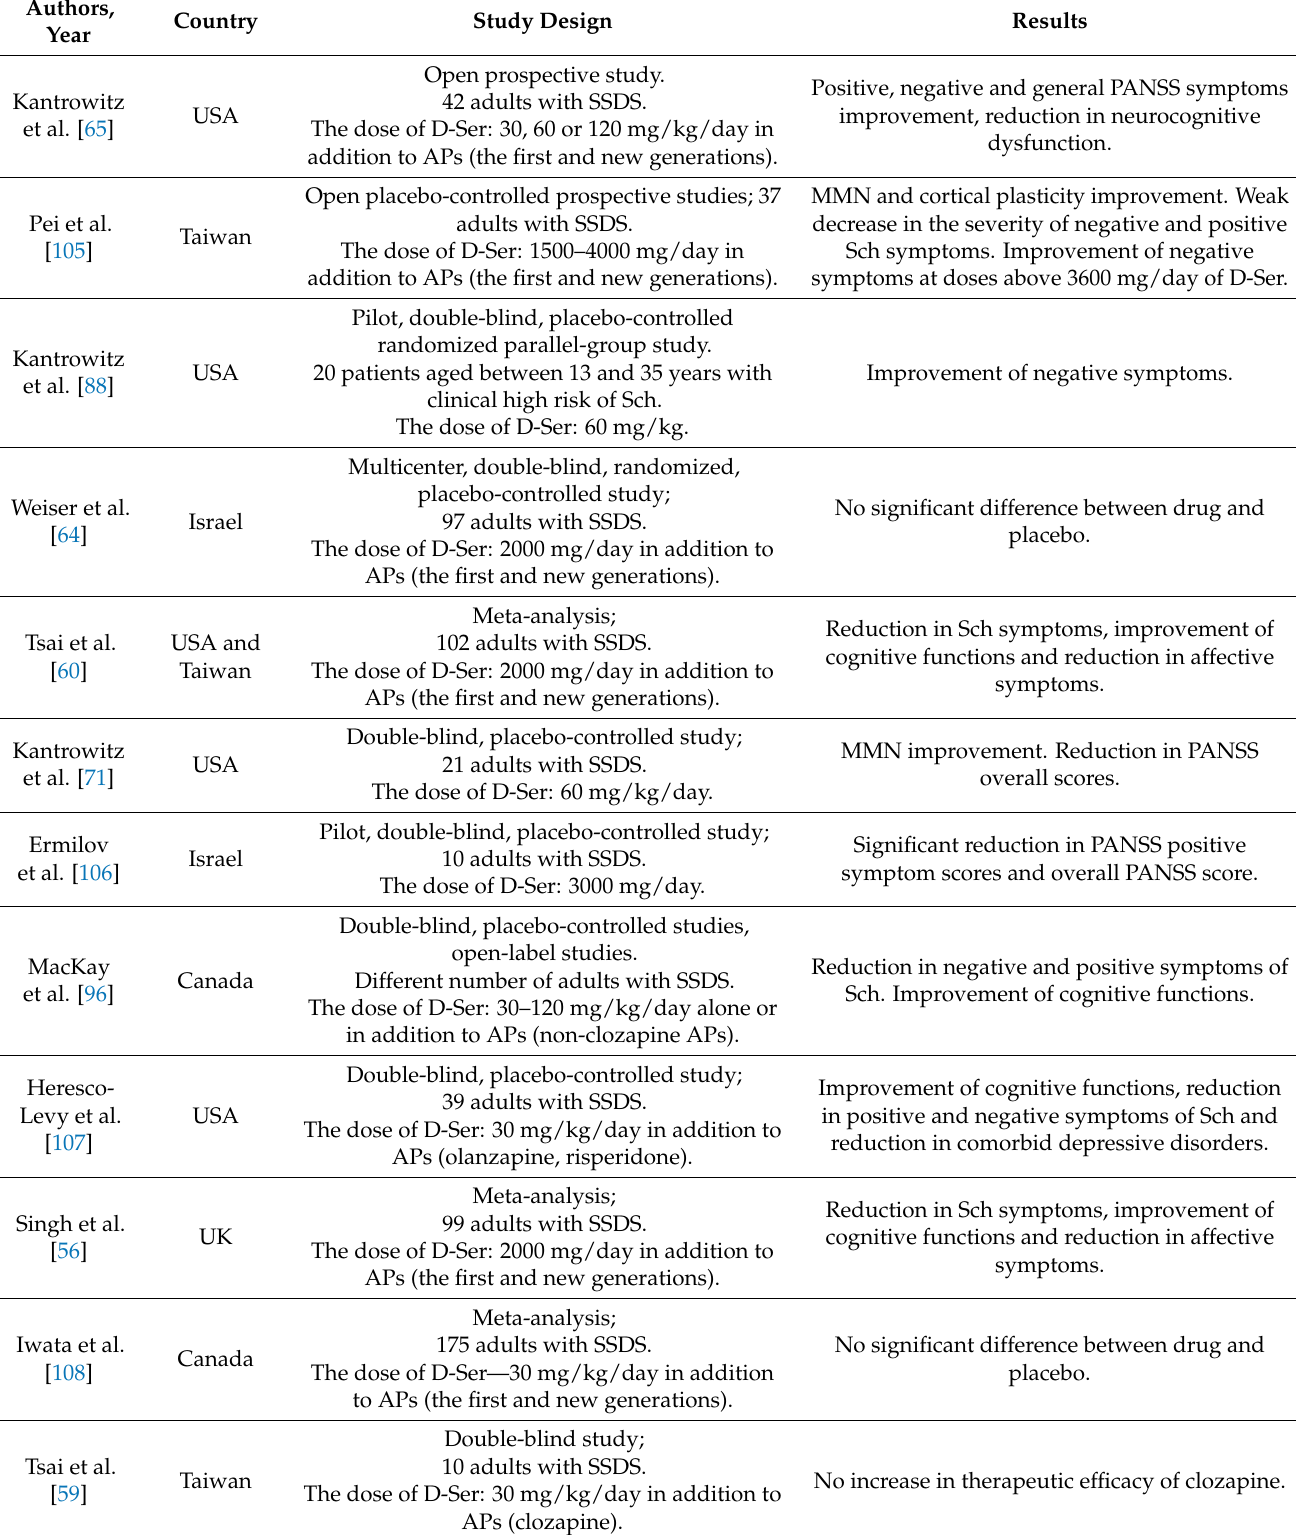
Table 4. Clinical studies of D-serine as a new therapeutic strategy for treatment-resistant